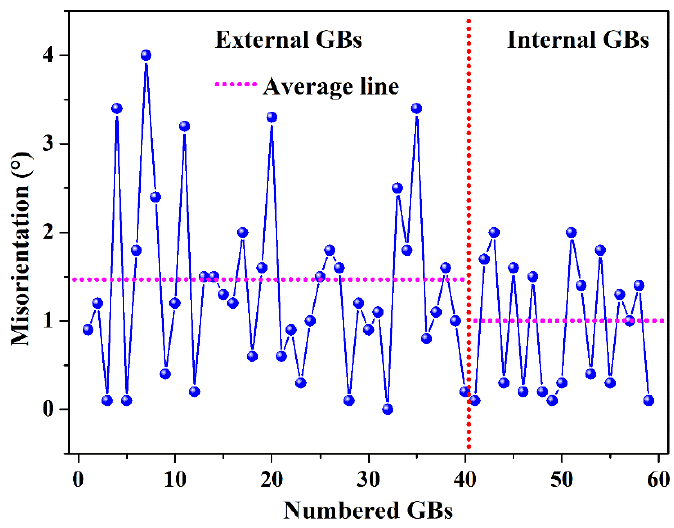
Figure 7. The differences in the misorientations before and after deformation.